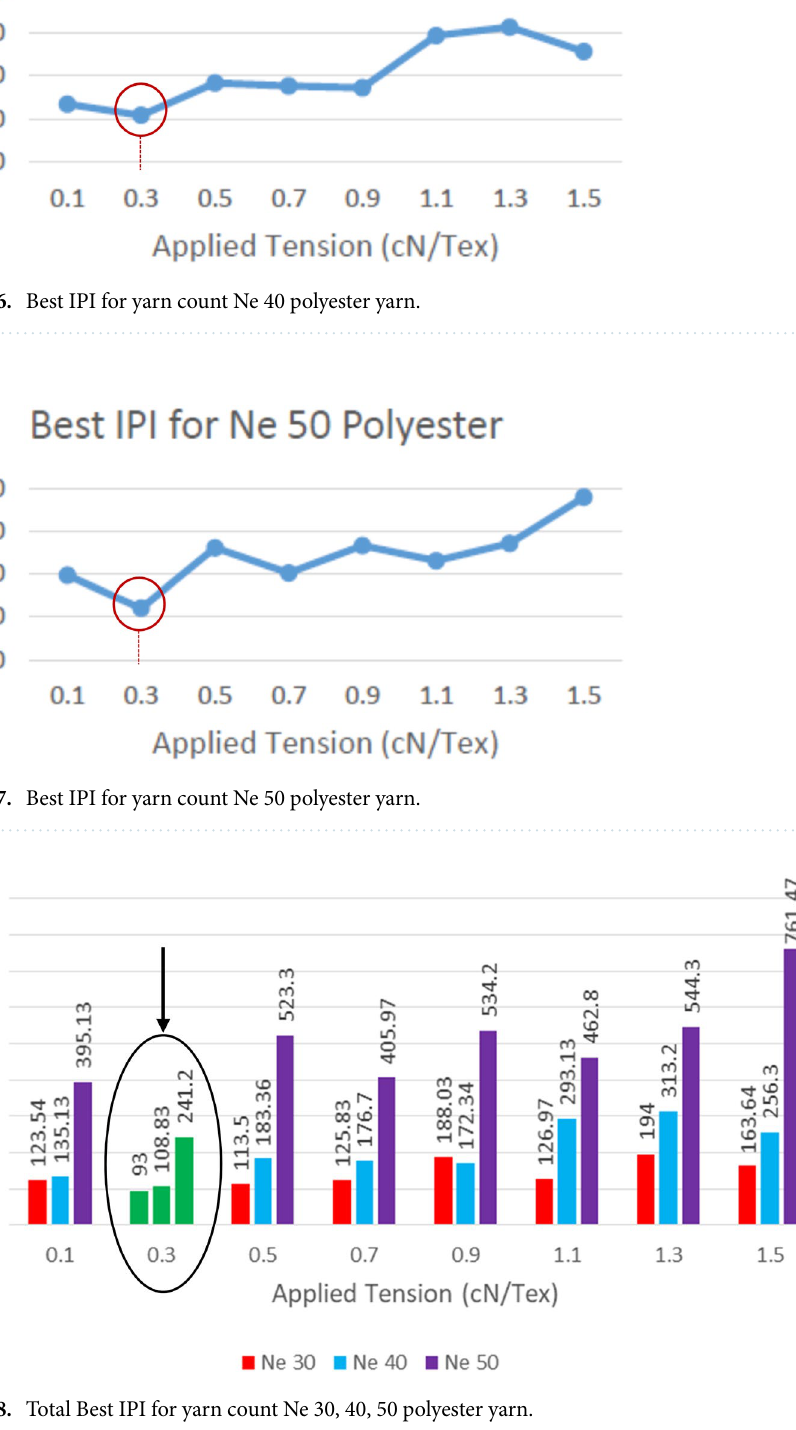
Figure 18. Total Best IPI for yarn count Ne 30, 40, 50 polyester